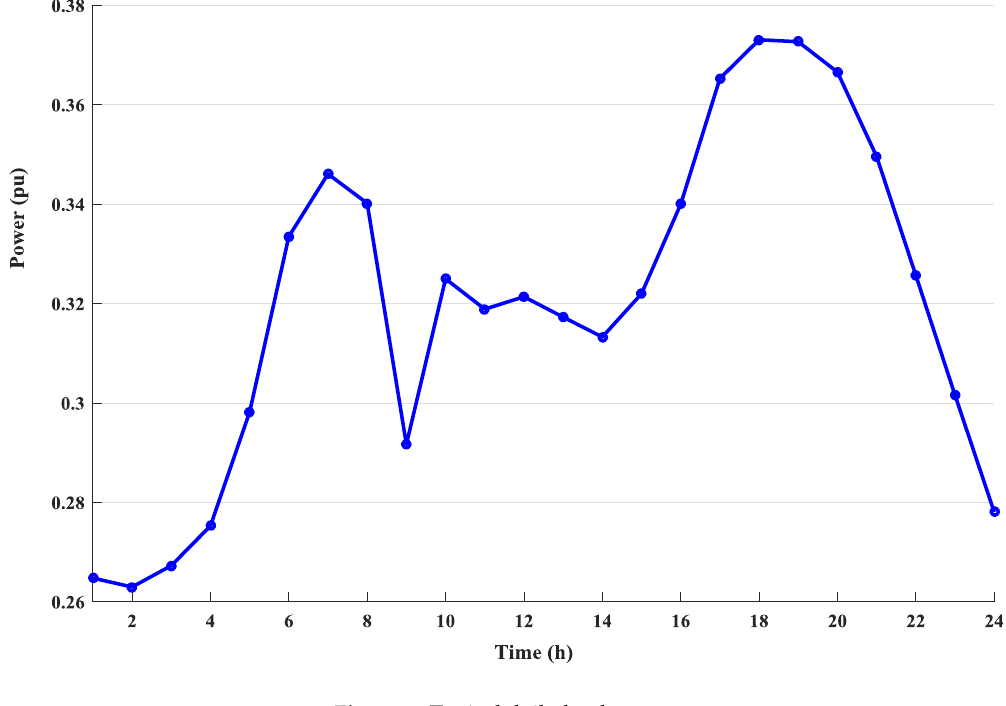
Figure 5. Typical daily load curve.